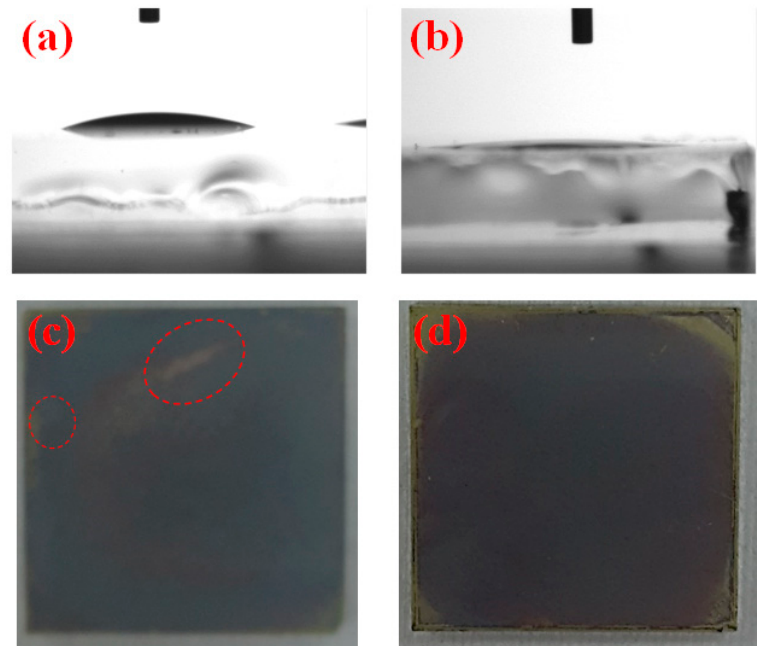
Figure 3. ( a , b ) Water contact angle (WCA) measurements of m-TiO 2 / c-TiO 2 / FTO substrate; ( c , d ) photo images of samples coated with the CH 3 NH 3 PbI 3 layer; ( a , c ) before UV-C light treatment; and ( b , d ) after UV-C light surface treatment.